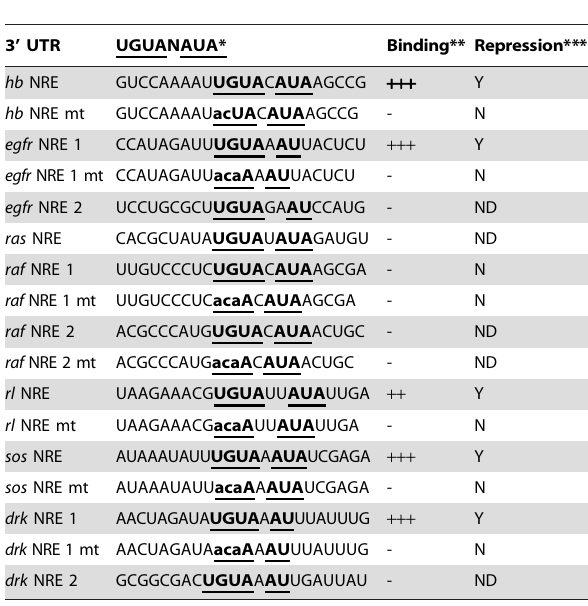
Table 2. Pum binding and repression of NRE-like sequences of EGFR and its transducers.